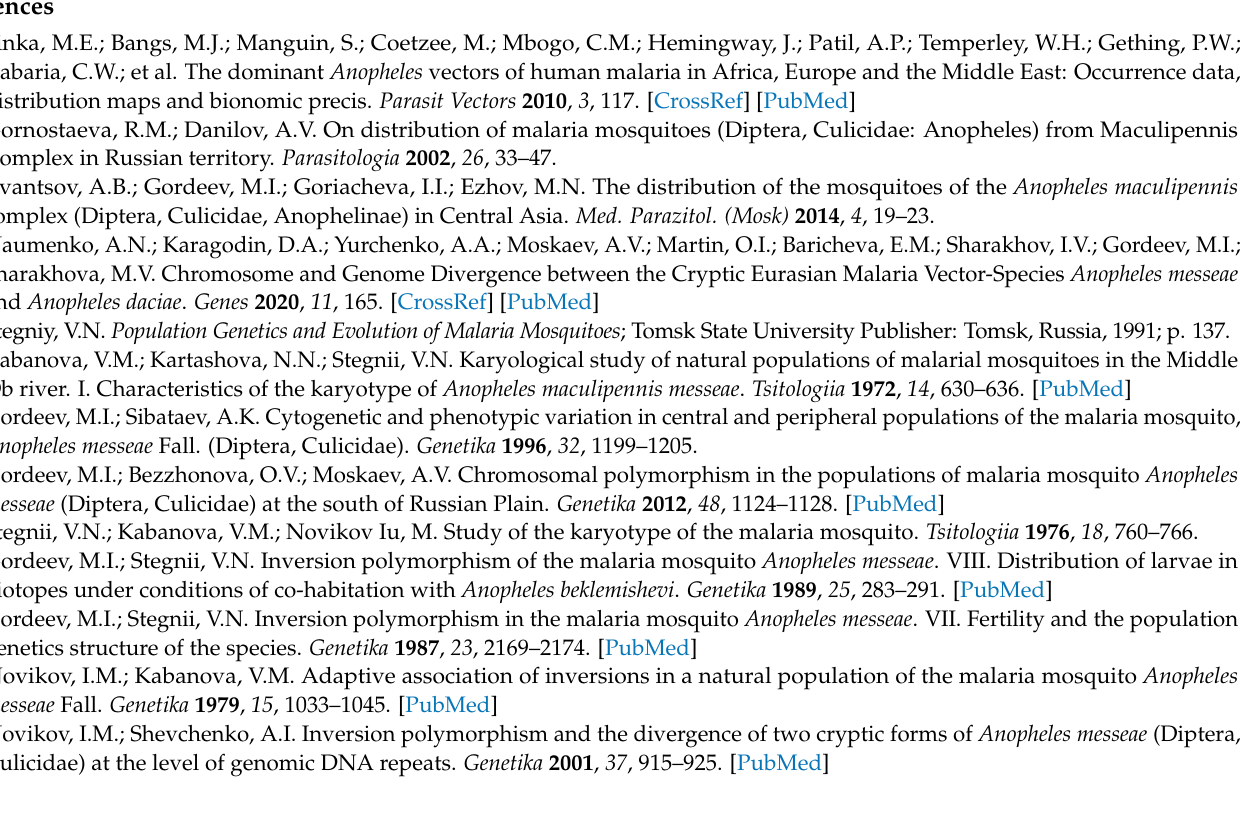
Table S1: Mosquito collections used for the development of the standard-universal chromosome map and illustration of the inversion variant composition. Species were identified by the PCR-RFLP approach using the RsaI endonuclease. Table S2. Genotyping results for specimens based on ITS2 sequences. Letters in sample numbers indicate their locations: IR—Irkutsk; KZ—Kazakhstan,